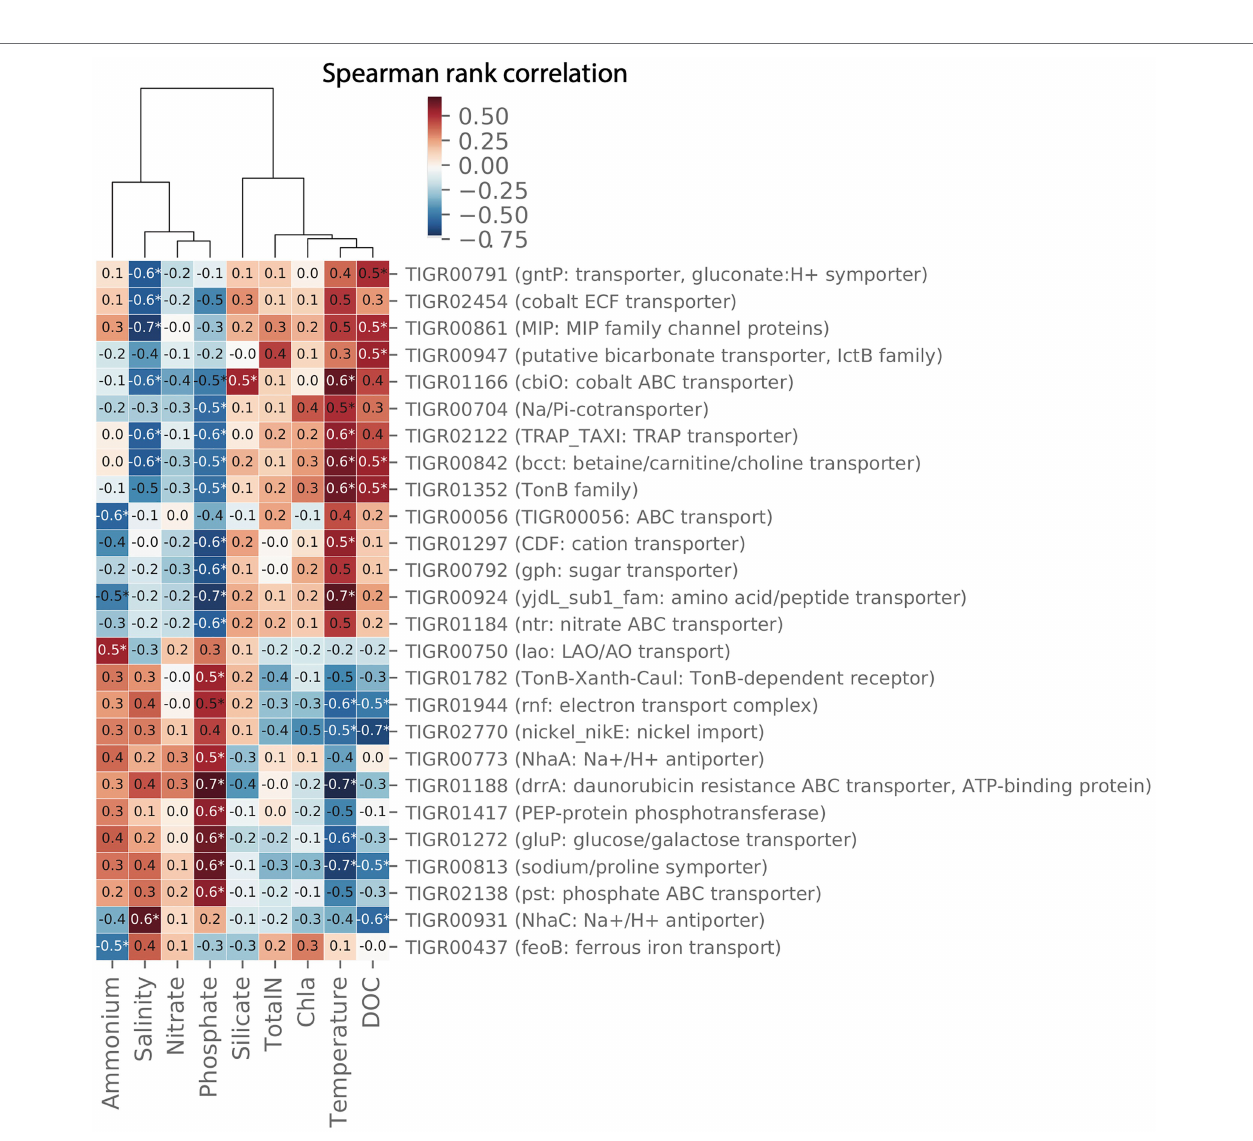
FIGURE 9 | Clustermap showing pair-wise spearman correlation metrics for environmental data and transporters in the 2012 LMO metagenome (MG) dataset. Only transporters with at least pair-wise correlation with Spearman rank correlation coefficient ( ρ ) > 0.5 and value of p < 0.05 are shown.